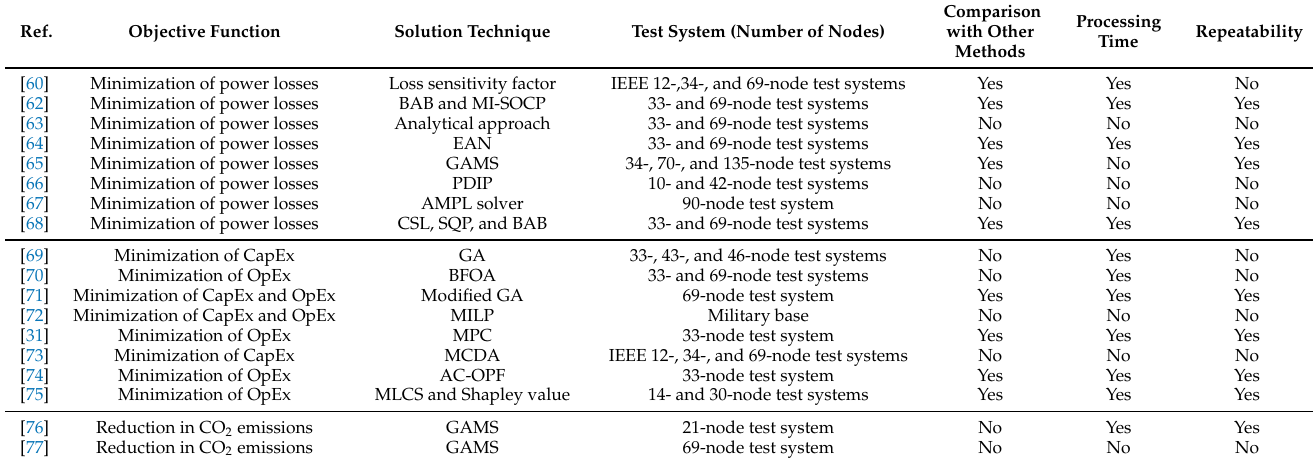
Table 1. Related studies found in the specialized literature and their